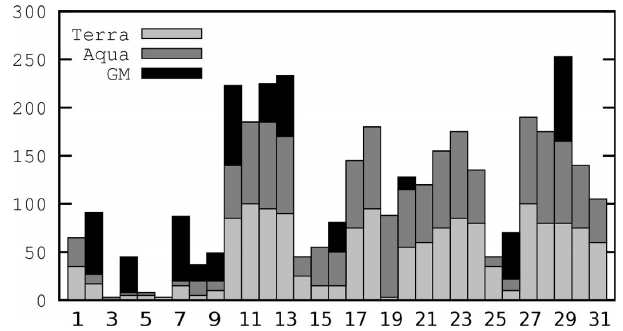
Fig. 6. Percentage of full flood extent covered on each day of Au- gust 2010 by MODIS Terra, MODIS Aqua and GM data.